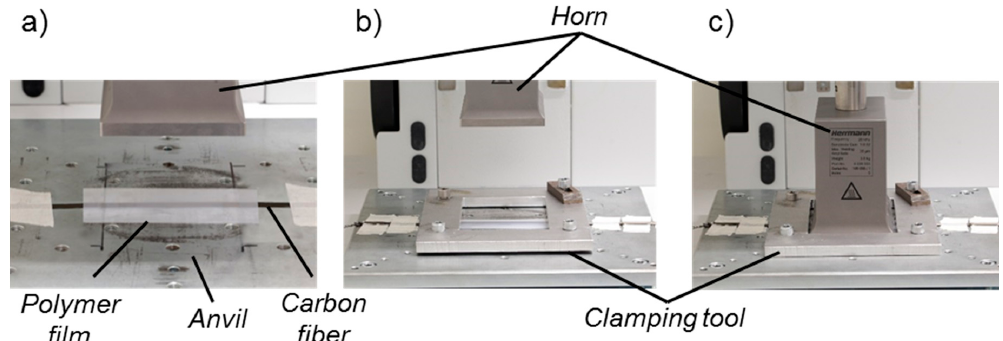
Figure 3. Positioning and fixing of the carbon fiber layers and the layers the polymer film on the anvil and under the horn of the Herrmann Ultraschall HiQ DIALOG 6200 ultrasonic welding machine. ( a